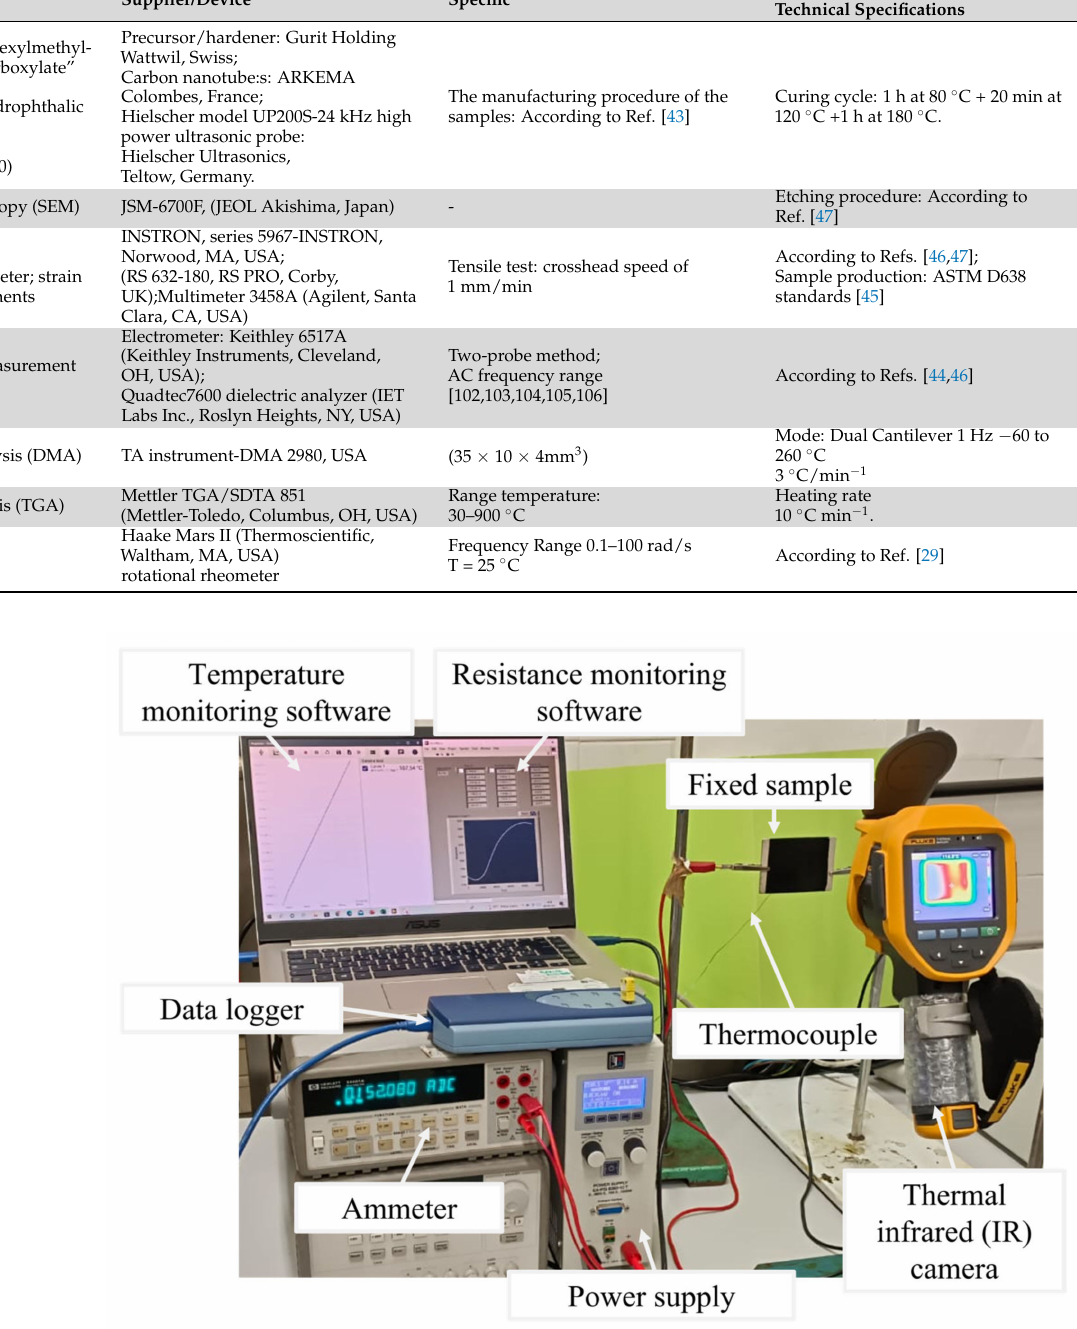
Figure 1. Equipment picture of the Joule heating